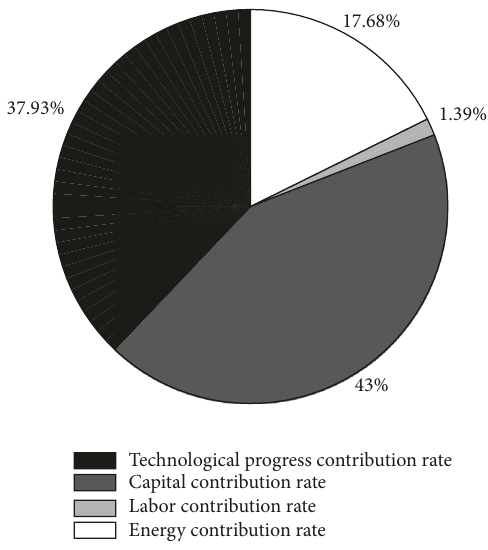
Figure 1: Pie chart of contribution rates of China’s economic growth